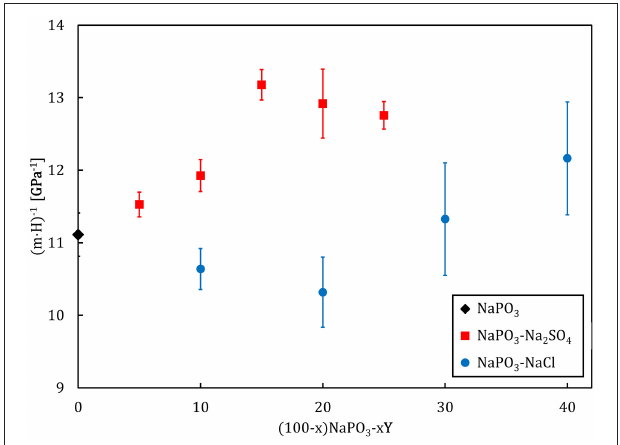
FIGURE 13 | Compositional dependence of the flow event volume, gauged by ( m · H ) − 1 , for the NaPO 3 -NaCl-Na 2 SO 4 glass system.